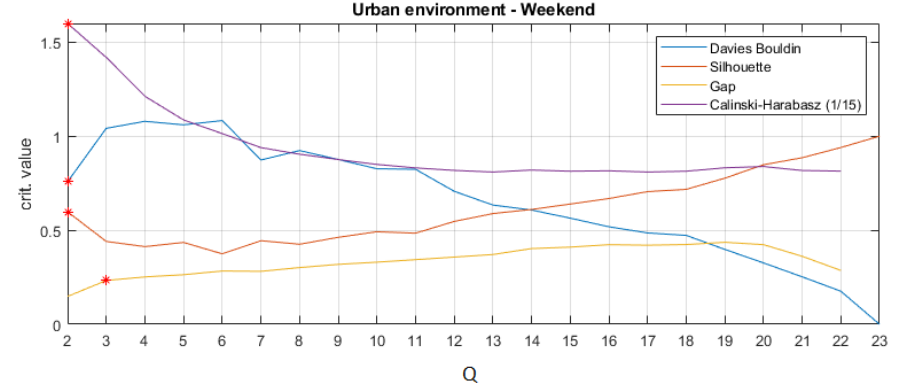
Figure 15. Clustering validity indices obtained for the acoustic urban environment at the weekend, resulting from the agglomerative hierarchical clustering algorithm for the considered number of clusters sweep 2 ≤ Q ≤ 18. The suboptimal number of clusters are marked as red asterisks, being the local maxima in all clustering indices despite the Davies–Bouldin index, which is a local